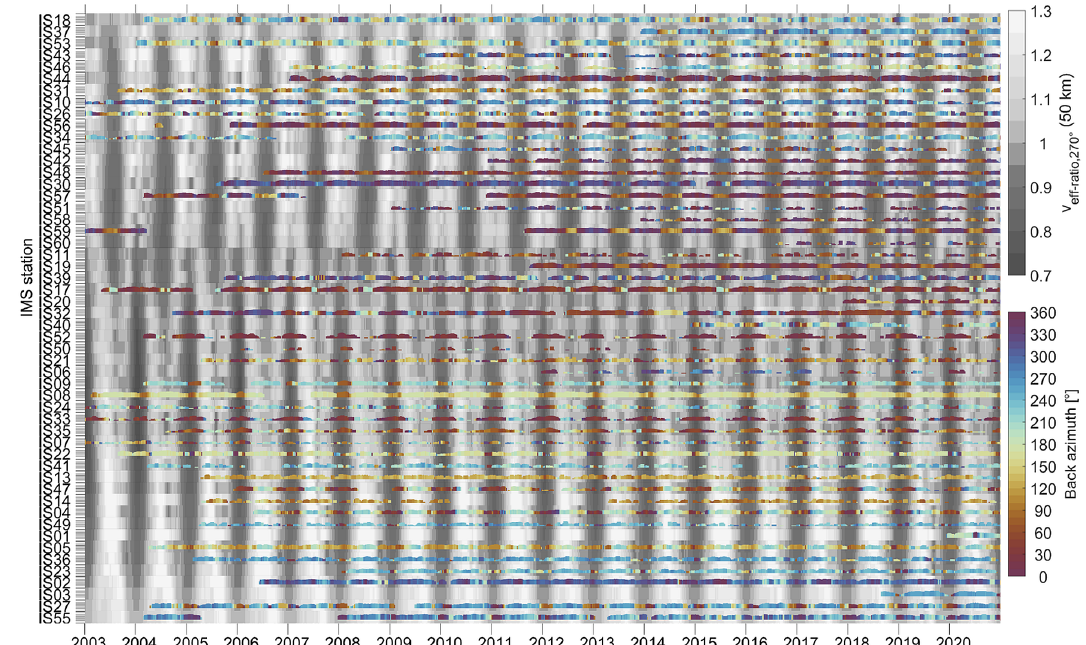
Figure C4. Similar to Fig. 13 but for the IMS infrasound detections in the maw frequency range (0.02–0.07Hz).